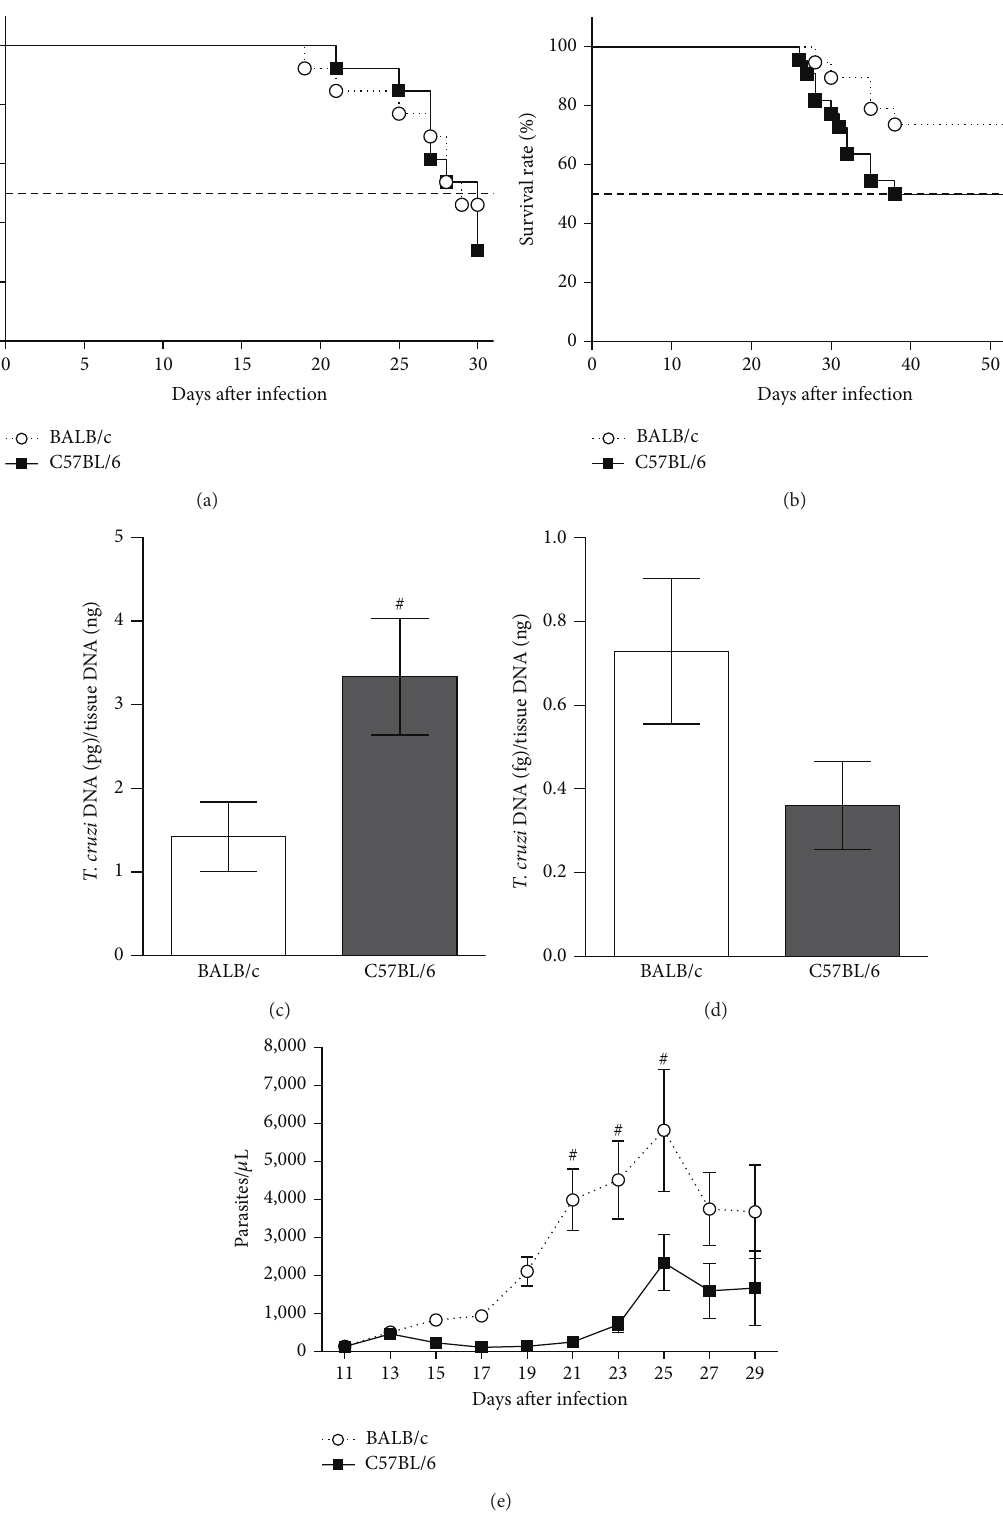
Figure 2: Survival, parasite load, and parasitism of T. cruzi infected mice. The male 8-week-old BALB/c and C57BL/6 mice were intraperitoneally infected with 10 3 or 10 2 bloodstream CL strain forms for acute and early chronic infections, respectively. For acute infection, the survival was observed daily during 35 days (a) and for early chronic infection the survival was observed daily during 60 days (b). The parasite load was determined in the heart at day 24 after infection for acute infection (c) and at day 60 after infection for early chronic infection (d). Parasitemia was quantified microscopically for 29 days (e). The data represent the mean ± SEM ( 𝑛 = 6 mice/group). # 𝑃 < 0.05 , comparison between BALB/c and C57BL/6 infected